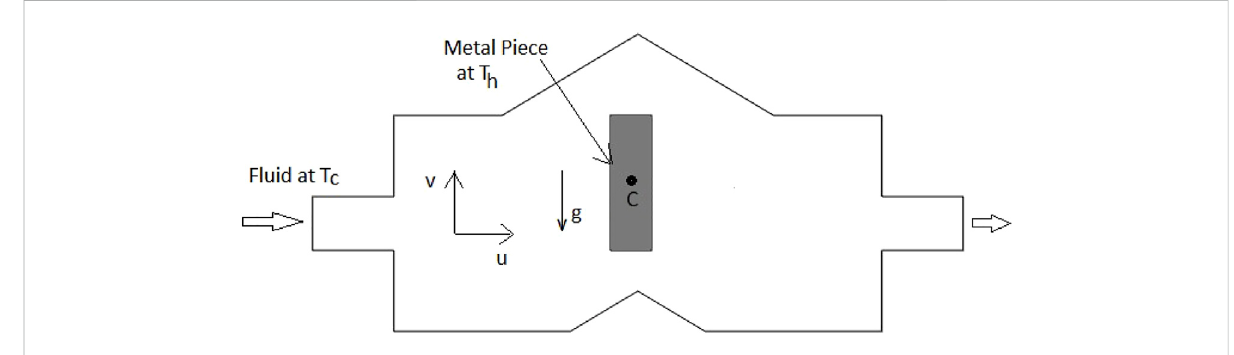
FIGURE 1 Geometry of cavity formed by fault.